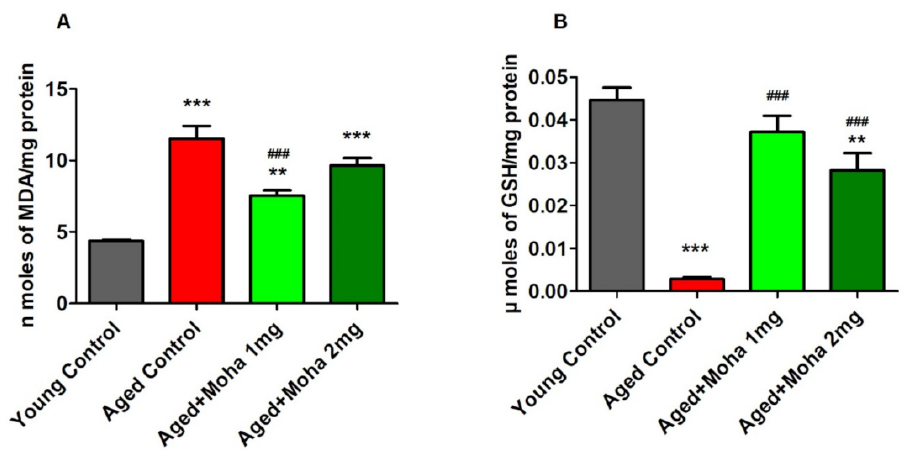
Figure 3. Effects of mahanimbine on ( A ) MDA and ( B ) GSH levels in brain homogenates of the aged mice mouse model. Administration of mahanimbine significantly reduced MDA levels and increased GSH levels in aged mice brains. All data were expressed as mean ± SEM ( n = 6). One-way ANOVA ( F (3,20) = 32.48, p < 0.001 for MDA level and F (3,20) = 33.39, p < 0.001 for GSH level) followed by Tukey–Kramer multiple comparisons test. ** p < 0.01 and *** p < 0.001 in comparison with young control; ### p < 0.001 in comparison with aged